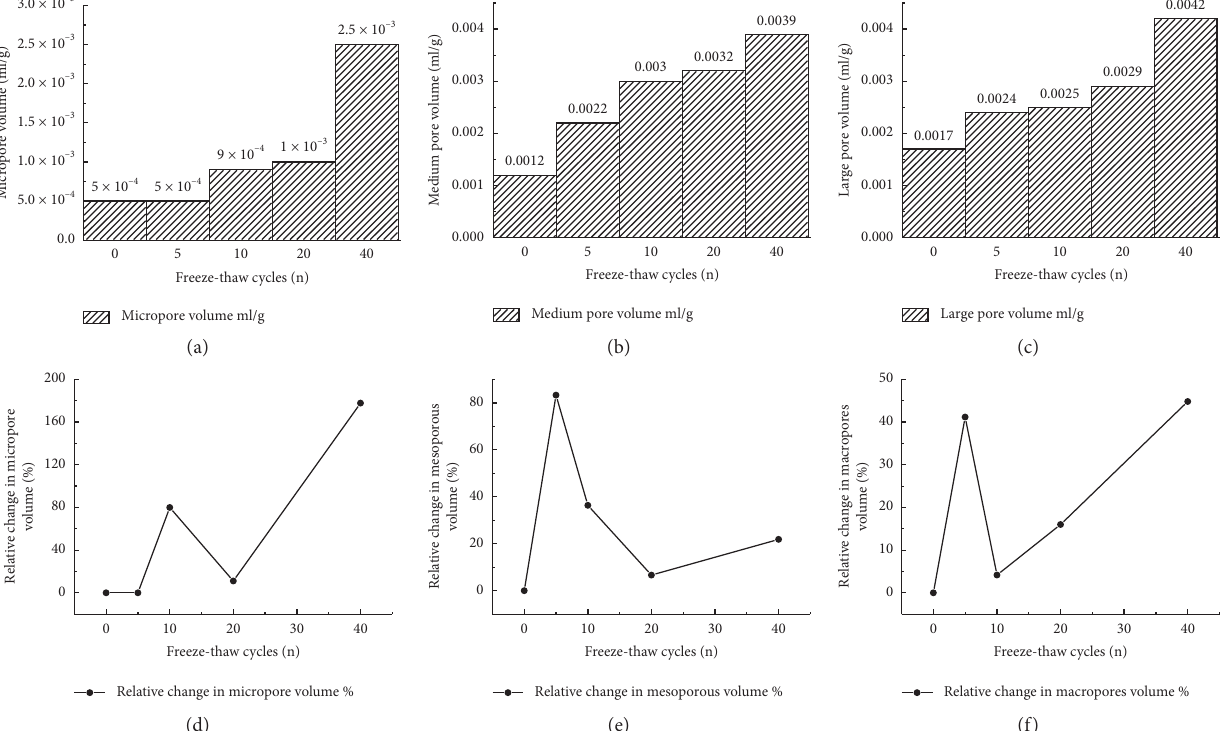
Figure 10: Pore volume and relative change amplitude of B in yellow sandstone under freeze-thaw cycles. (a) Micropore volume. (b) Mesoporous volume. (c) Macropores volume. (d) Relative change in micropore volume. (e) Relative change in mesoporous volume. (f) Relative change in macropores volume.